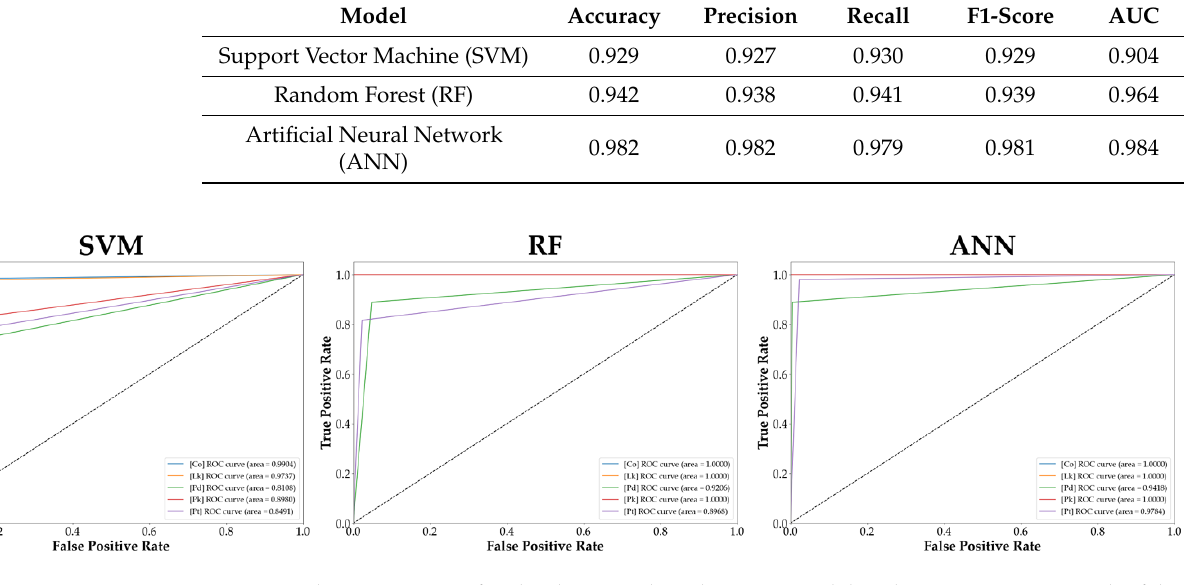
Figure 6. The ROC curves for the three machine learning models. The x-axis represents the false positive rate, and the y-axis represents the true positive rate.